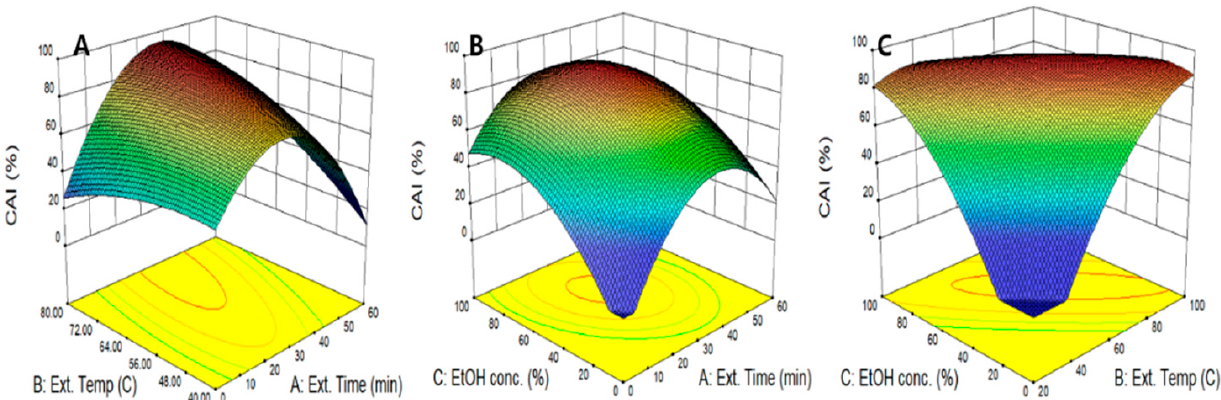
Figure 4. Response surface plots for CAI of peanut shell extracts according to extraction time, extraction temperature, and ethanol concentration. CAI as a function of extraction temperature and extraction time ( A ), extraction time and ethanol concentration ( B ), and extraction temperature and ethanol concentration ( C ).